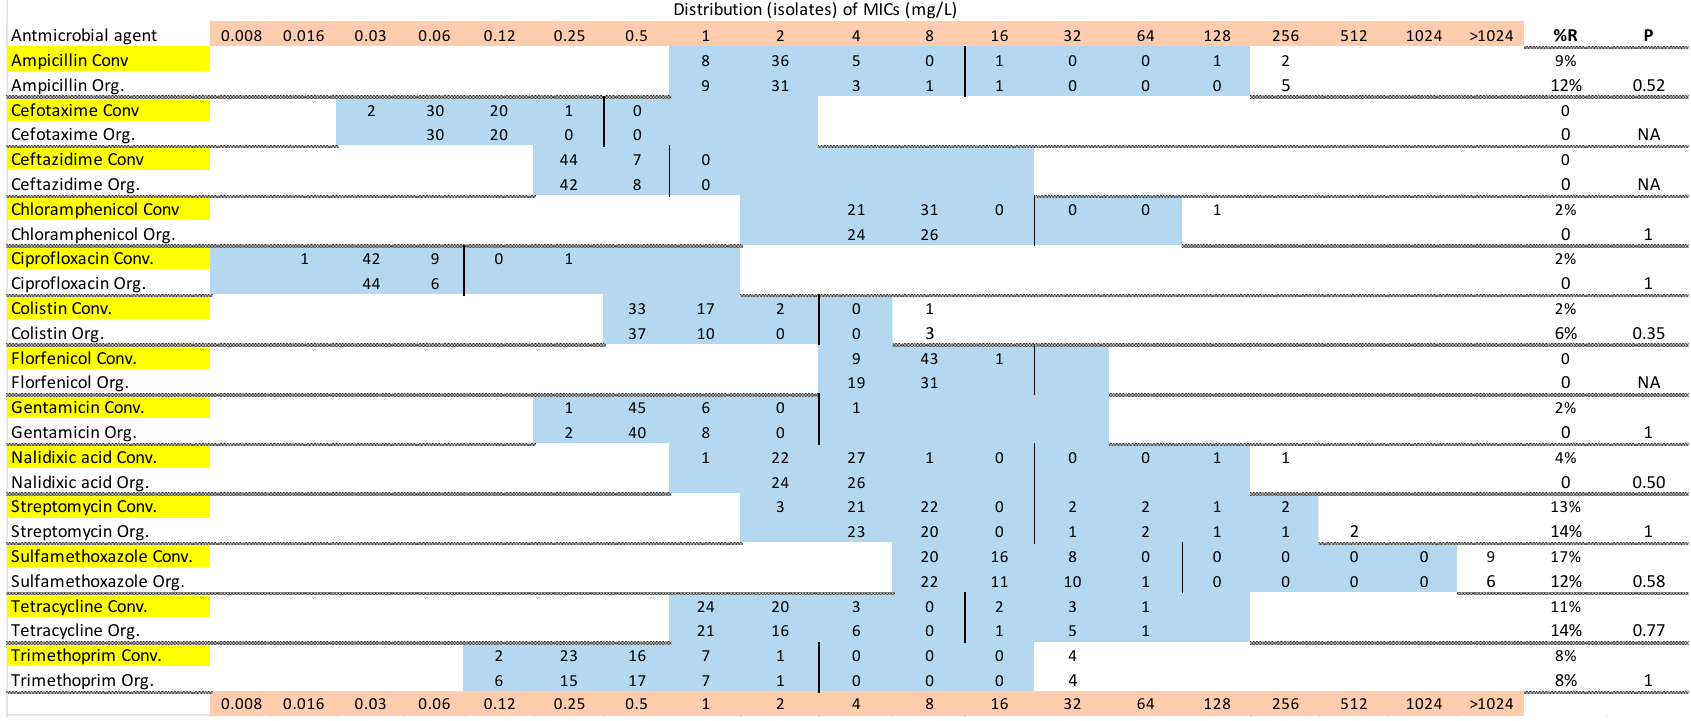
Figure 3. Minimum inhibitory concentration (MIC) distributions of Escherichia coli isolates from environmental samples of farm manure (drainage and manure pit) at the beginning of period 2, in 27 (50 isolates) organic (Org) and 27 (53 isolates) conventional (Conv) Swedish dairy herds, in a panel of 13 antimicrobial agents. Blue color indicates the range of concentrations tested. Vertical thicker black lines are the epidemiologic cut-off points according to EUCAST. p values test the difference between organic and conventional herds with Fisher’s exact test. Yellow color denotes isolates from conventional herds and pink color shows MIC values.